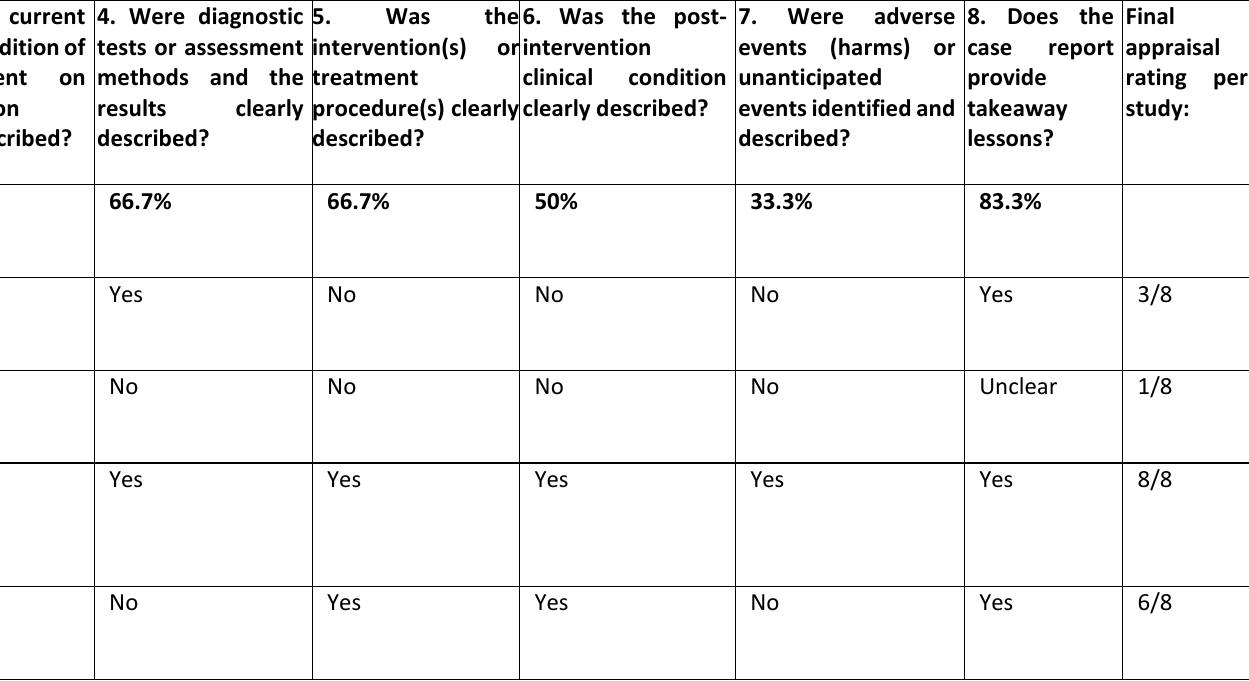
TABLE 5-A1: Case reports detailed critical